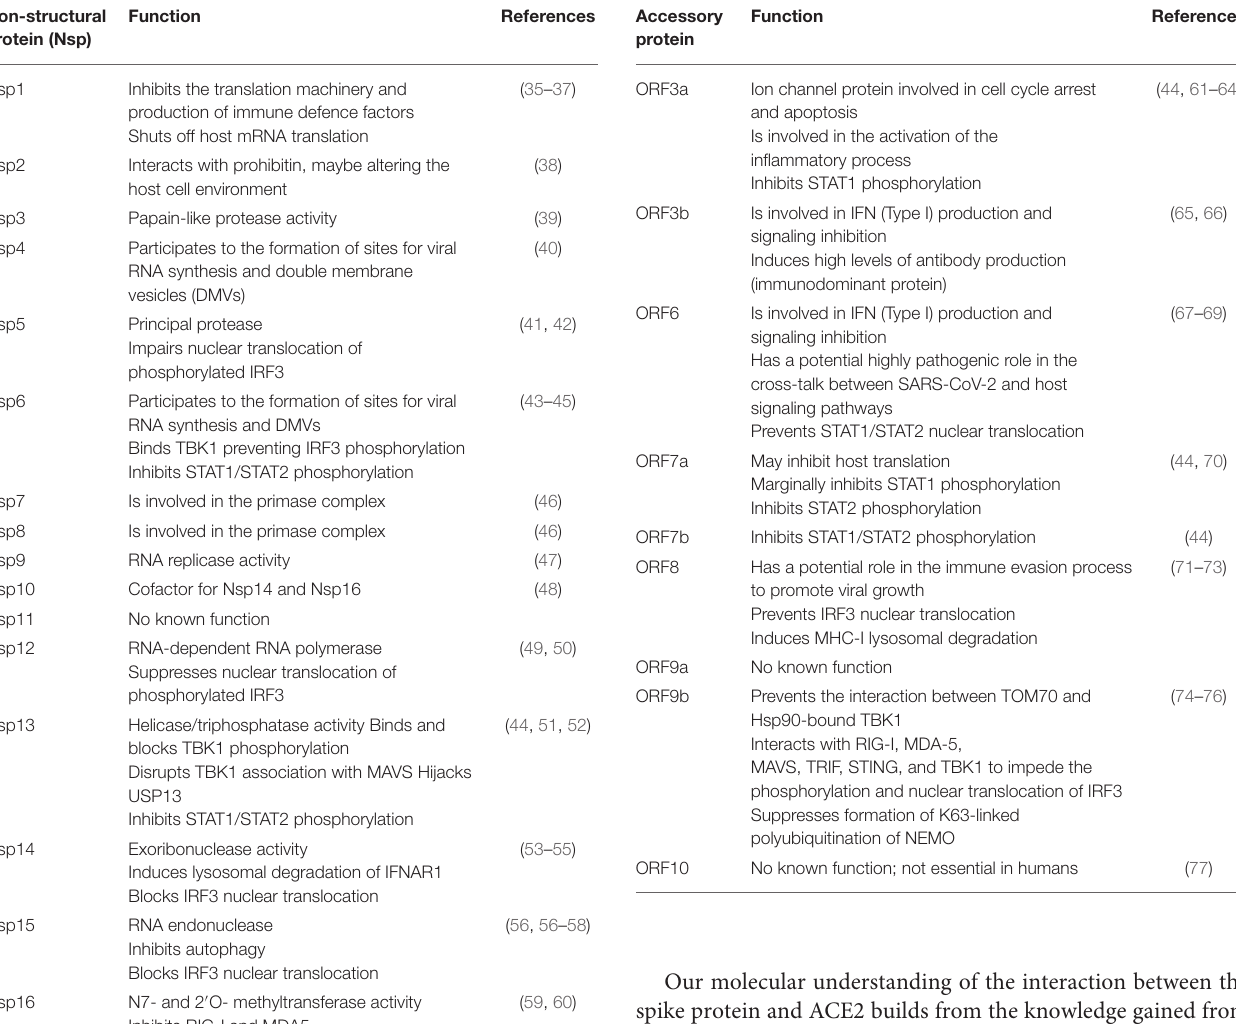
TABLE 2 | Non-structural proteins encoded by SARS-CoV-2 genome and their functions. Non-structural Function protein (Nsp)